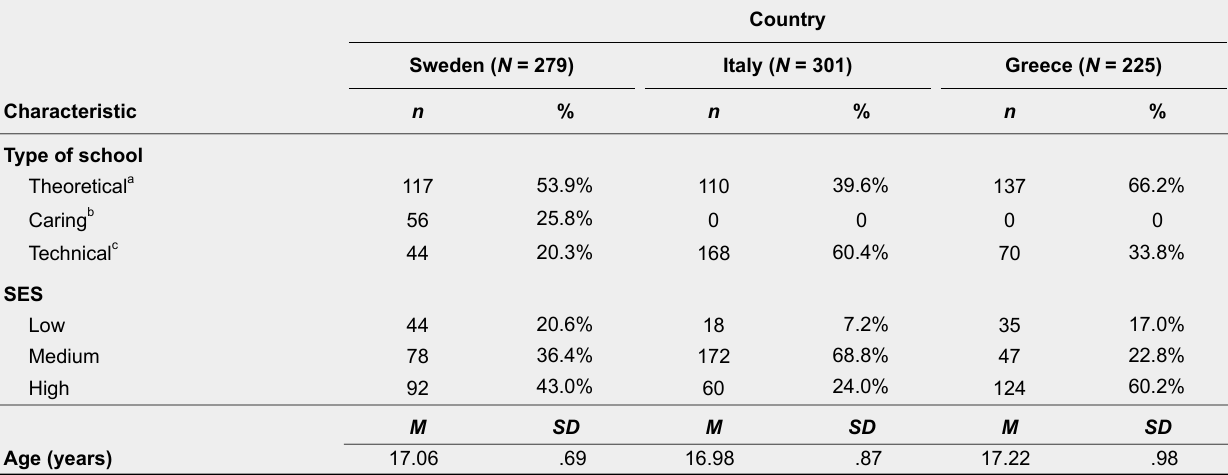
Demographic Characteristics of the Participants by